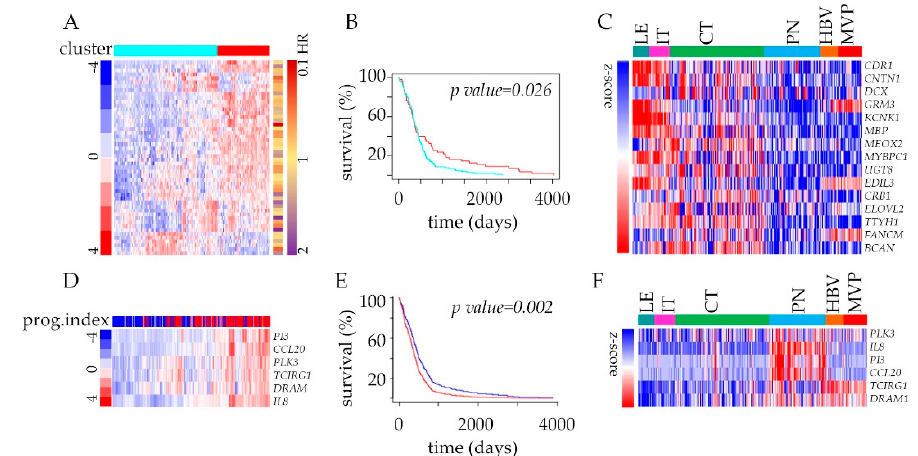
Figure 4. Survival estimator analysis of glioblastoma patients from TCGA based on the cluster membership of genes in the Ivy GAP dataset: ( A ) Heatmap with color annotations according to profile similarity (blue/red) of 50 most down-regulated genes (based on differential analysis of CT and PN zones, n = 2707) annotated with Hazard Ratios (HR red-violet) from Cox analysis. ( B ) Survival analysis of TCGA GBM samples dataset stratified according to their cluster membership (blue/red) from panel ( A ) using Kaplan–Meier analysis. ( C ) Heat map of RNA-seq expression correlation data for 15 (with p -value < 0.01) from 50 gene signature in all glioblastoma anatomic features is shown. ( D ) Hierarchal clustering analysis of a full cohort of TCGA GBM samples dataset stratified by inspecting the status of genes ( n = 6) with the most prognostic index (based on autophagy ( n = 64) and immune mode ( n = 451) genes’ inputs). ( E ) Survival analysis based on the impact of the 6-gene from panel ( D ) with prognostic index hazard ratio = 1.61 and log-rank p -value = 0.002 in a full cohort in TCGA GBM samples dataset using Kaplan–Meier analysis. ( F ) Heat map of RNA-seq expression correlation data for six genes from panel ( D ) signatures in all glioblastoma anatomic features is shown.